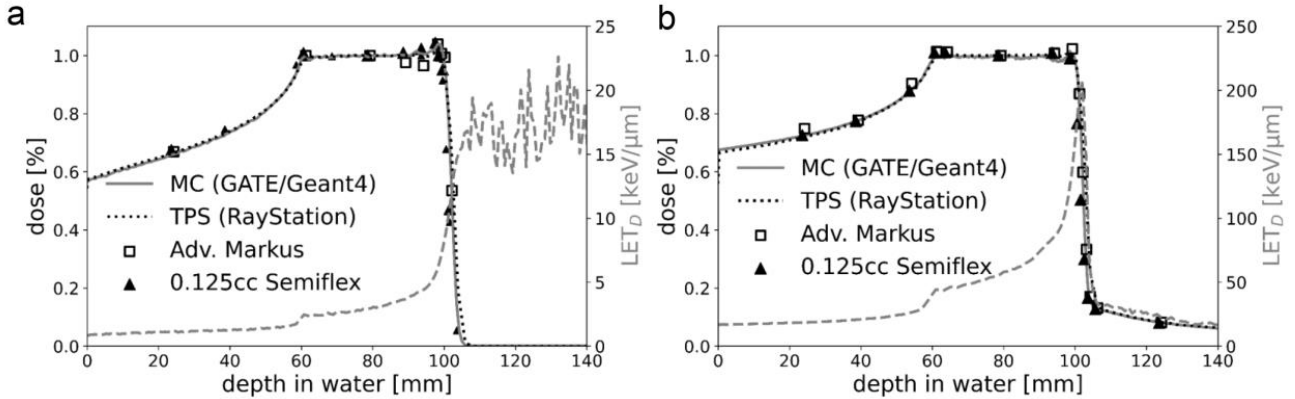
Figure 3. Physical characteristics of particle IR. The percentage depth dose curves of the ( a ) proton and ( b ) C-ion SOBP used for cell IR. A very good agreement between the predicted dose distributions of the treatment planning system (TPS) and the Monte Carlo (MC) simulation was achieved. The respective LET spectrum shows the increase with increasing depth in water. C-ions have a much higher LET than protons, which is reflected by the scale of the mirrored y -axis (25 keV/ µ m vs. 250 keV/ µ m). For protons, the LET after the fall-off region has no physical meaning as no particles are delivered beyond this depth.